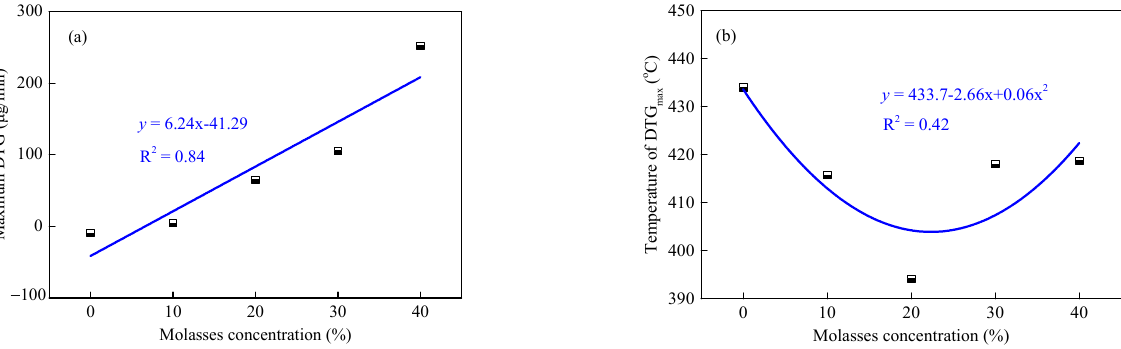
Figure 10. The maximum of the DTG (DTG max ) at 150–300 ° C ( a ) and the temperature corresponds to the DTG max at >300 ° C ( b ).